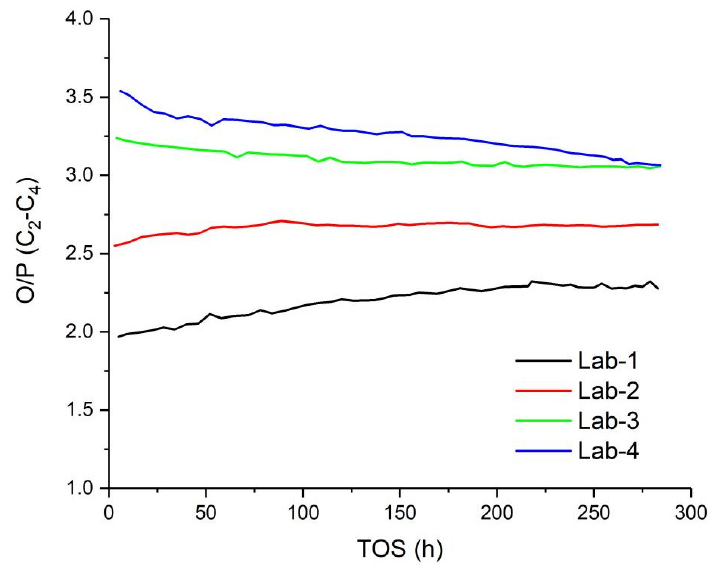
Figure 12. Olefin-to-paraffin ratio in the C 2 –C 4 section with time in-stream over the samples (reaction conditions: FBR, 2.3 MPa, 235 °C; Activation: H 2 /CO = 20, 260 °C, 24 h).